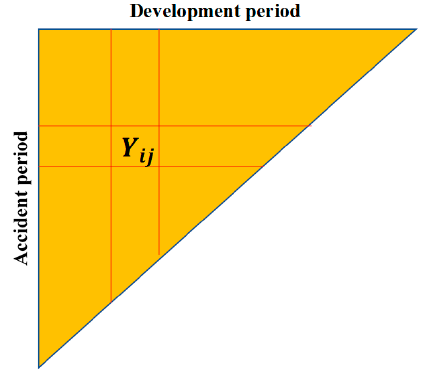
Figure 1. Illustration of the data triangle.